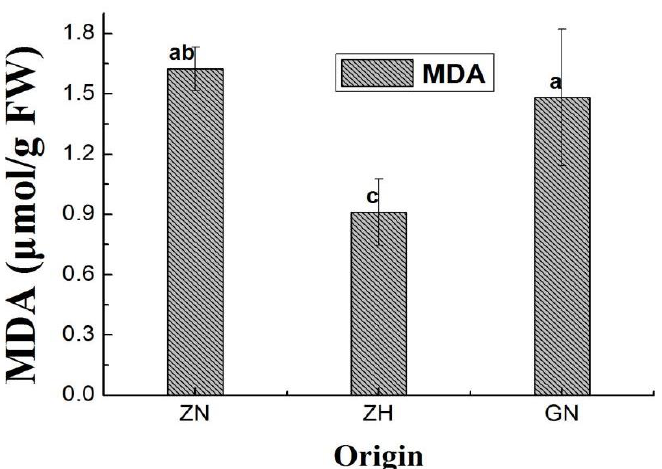
Figure 4. MDA contents of K. obovata seedlings. FW stands for sample fresh weight . Different letters indicate significant difference among sources at the same sampling time according to one-way ANOVA at P < 0.05. GN: normal leaves from Zhanjiang, Guangdong; ZH: the half-wilted leaves from Zhoushan, Zhejiang; ZN: the normal leaves from Zhoushan,